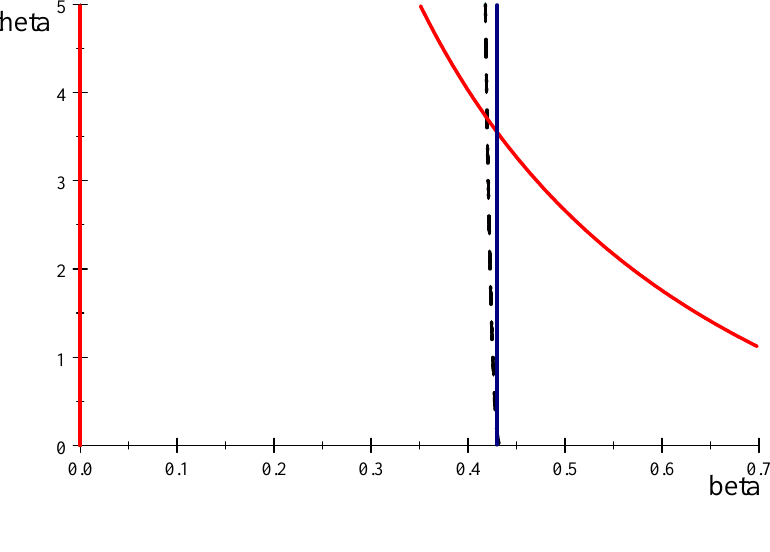
Figure 10: Changes of labour market tightness with respect to leisure value: